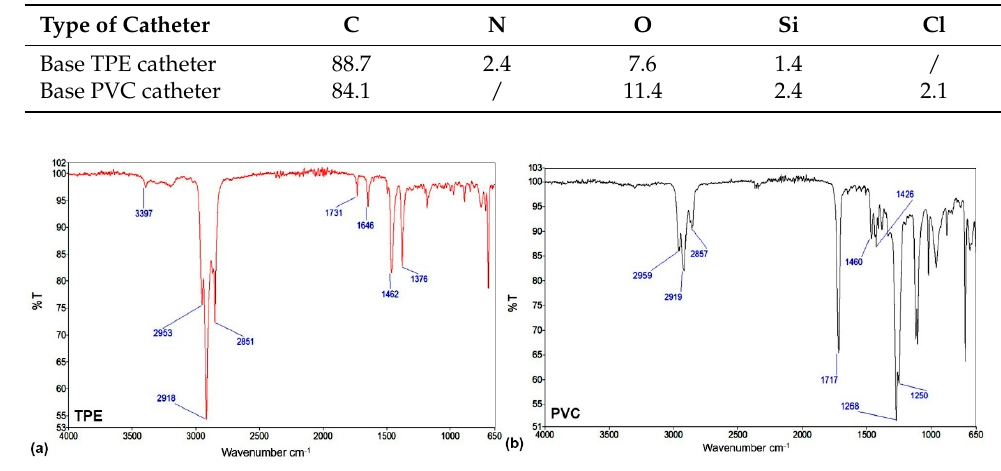
Figure 1. FTIR spectra of reference catheters: ( a ) TPE catheter and ( b ) PVC